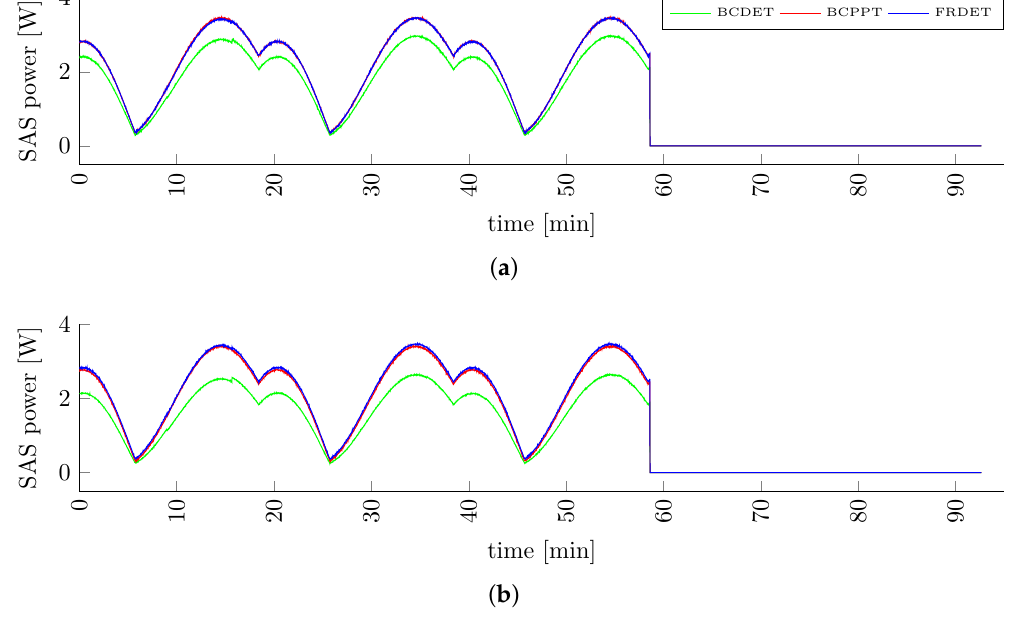
Figure 11. SAS harvested power for initial OCV of: ( a ) 4.0V; ( b ) 3.5V.